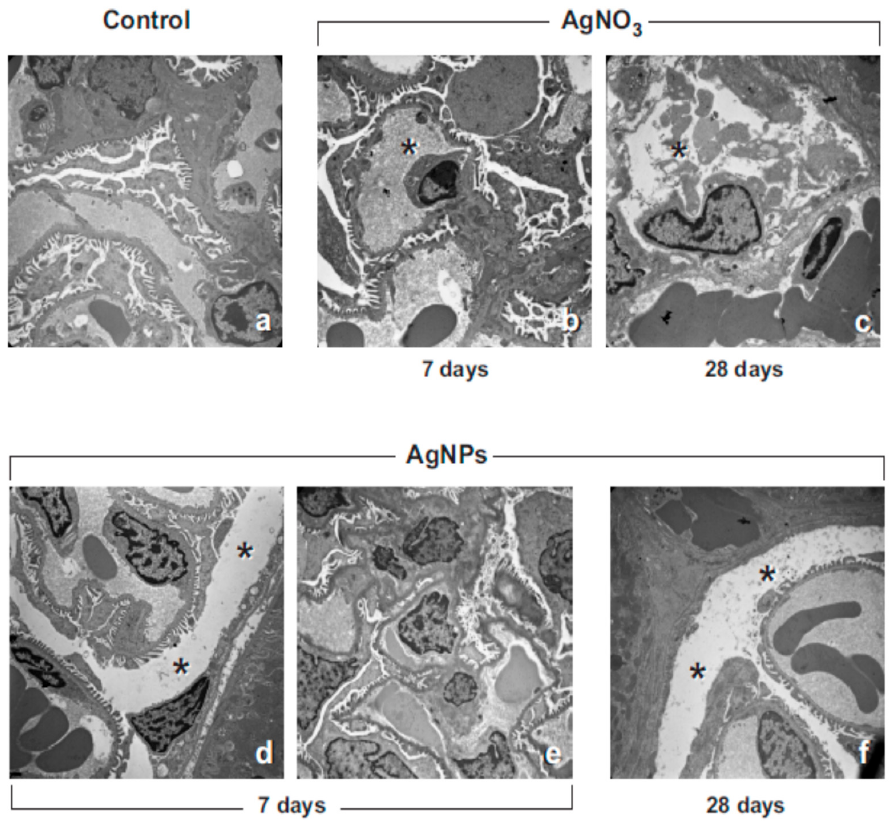
Figure 3. Transmission electron microscopy images (UA & LC staining) showing moderate renal cortical alteration 7 and 28 days after AgNP- and AgNO 3 -instillation. The evident dilatation (asterisks) of the intercapillary and peripheral Bowman’s space ( d , f ) is shown together with shrinkage of both mesangial cells and glomerular capillaries; endothelial and podocytic cells appeared damaged ( b , c , asterisks), the latter showing the podocyte foot processes scarcely developed ( e ). Occasional expression of cell injury, namely apoptotic cell death and cytoplasm segmentation are also presented ( b , c ). Original magnification: ×4400 ( a – c ); ×3000 ( d – f ).